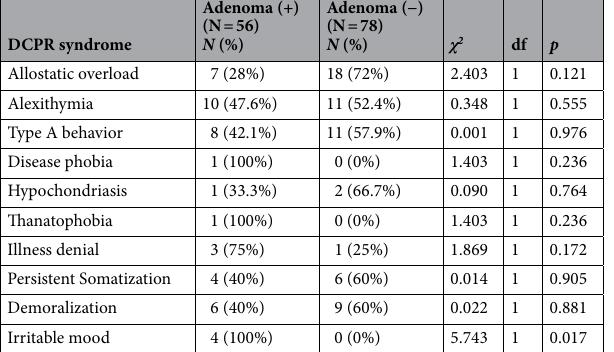
Table 4. Association between adenomas and psychosomatic syndromes (DCPR). DCPR Diagnostic Criteria for Psychosomatic Research, (+) Presence of adenomas (treated with polypectomy), (−) Absence of